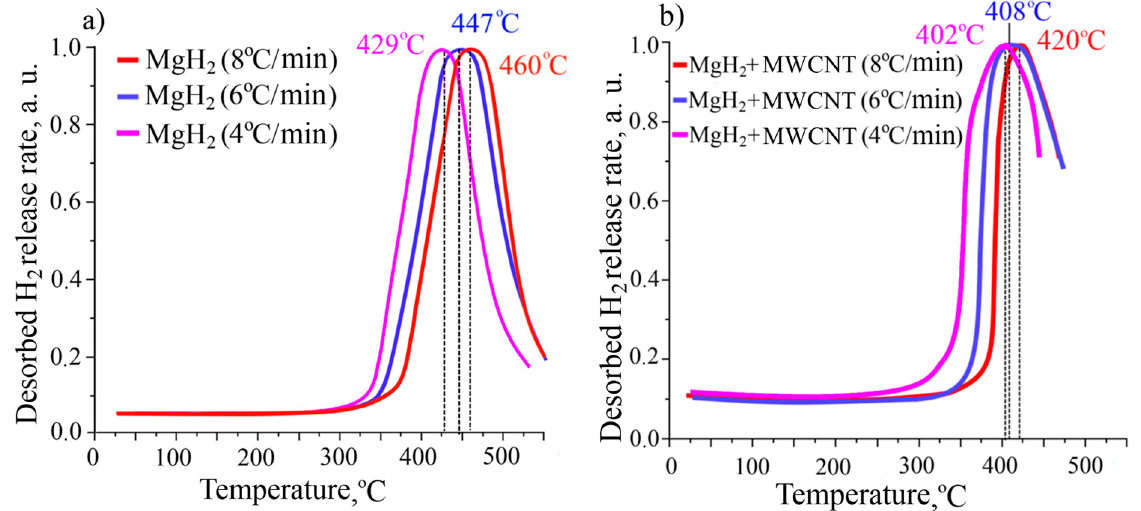
(cid:3081) (cid:2869)(cid:2868)(cid:2868)(cid:2868) versus for magnesium hydride and (cid:3021) (cid:3265)(cid:3118) (cid:3021) (cid:3291)